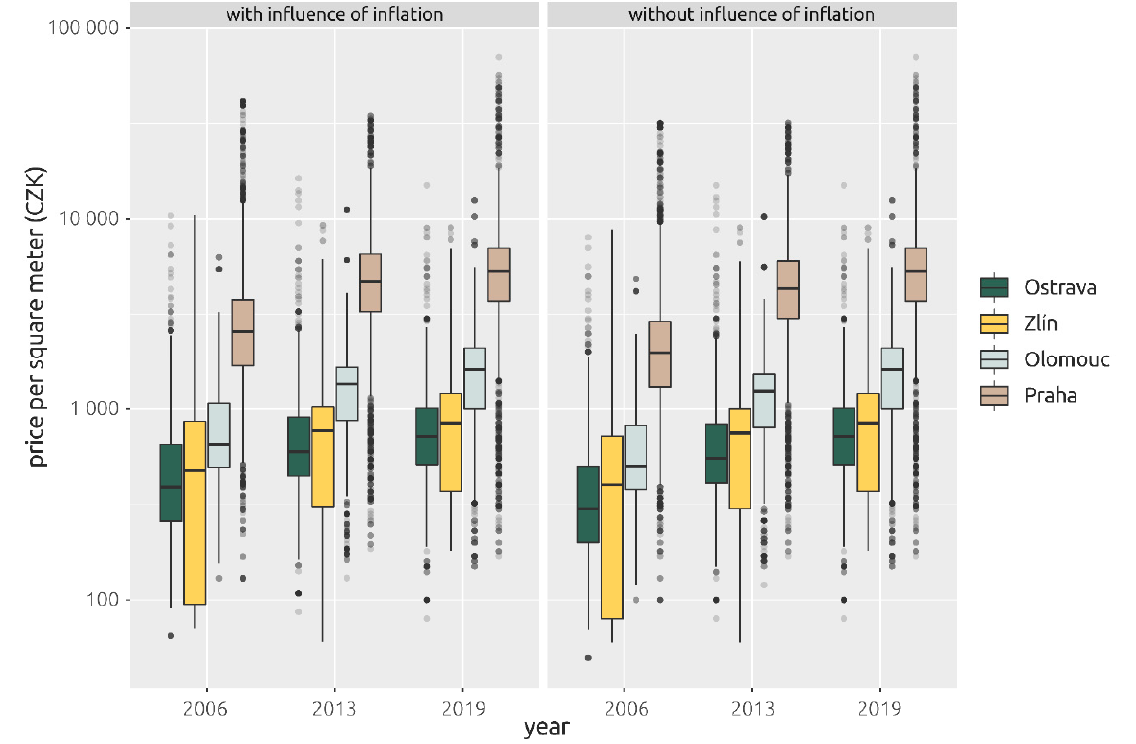
Figure 3. Parcel price changes in the monitored cities between 2006 and 2019.